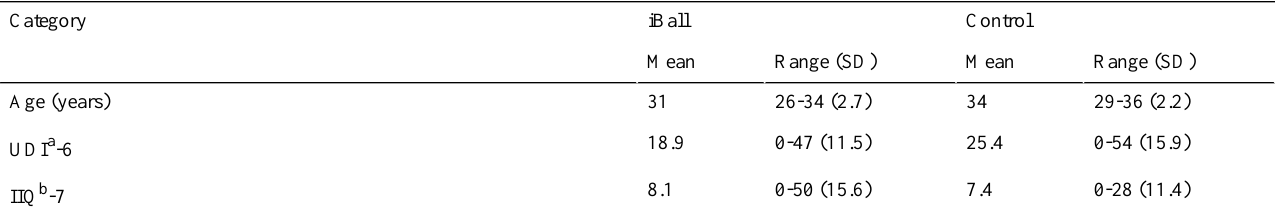
Table 2. Baseline characteristics and participant demographics: urogenital distress inventory and Incontinence Impact Questionnaire scores.